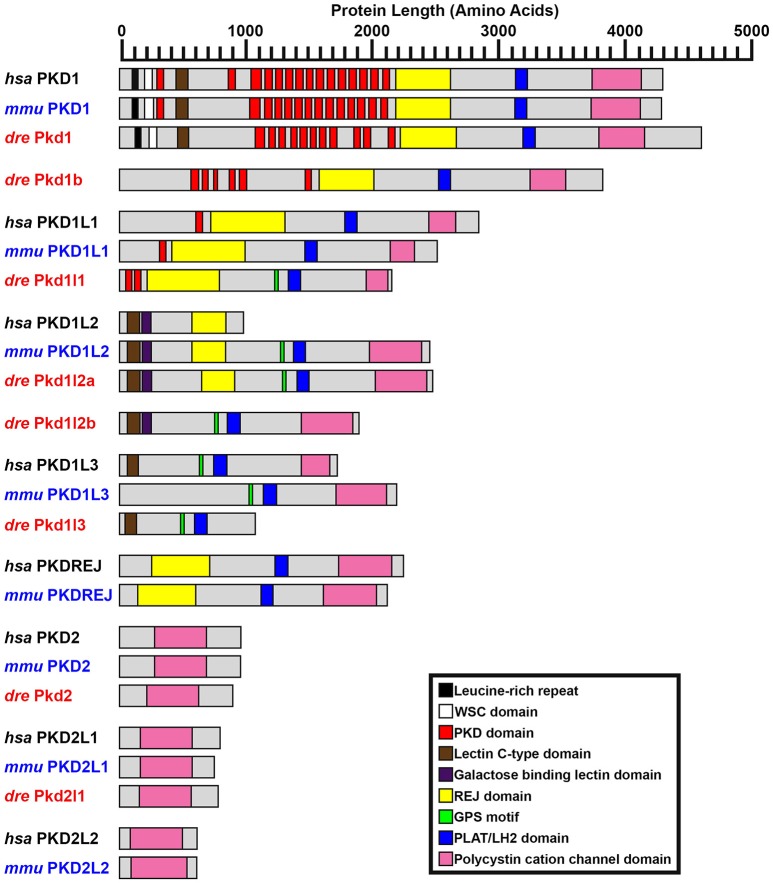
PKD protein domains. Schematics of protein domains identified in all eight human (Homo sapiens, hsa) and mouse (Mus musculus, mmu) and seven zebrafish (Danio rerio, dre) PKD proteins. The zebrafish putative partial pkd1l3 ortholog is also shown. Approximate protein length is indicated by scale at top. Where multiple transcripts exist in Ensembl, the longest protein isoform is shown. In all three species, PKD1 is the longest PKD protein and the only protein to contain a leucine-rich repeat and carbohydrate-binding WSC domain in the amino-terminus. Pkd1b is not present in mammals. Zebrafish Pkd1b resembles Pkd1 with multiple PKD domain repeats in the amino-terminus and REJ, PLAT/LH2, and polycystin-cation-channel domains in the carboxy-terminus. In all three species, PKD1L1 contains a shorter polycystin-cation-channel domain, approximately half the size of that in other Pkd proteins. Unlike mammals, zebrafish Pkd1l1 also contains a GPS motif upstream of the PLAT/LH2 domain. The 5′ coding sequence of mouse Pkd1l1 gene is presently incomplete. PKD1L2 is unusual in humans in that, according to information on Ensembl, longer transcripts represent polymorphic pseudogenes that have acquired mutations, preventing them from being expressed as functional proteins. As a result, the current version of human PKD1L2 is half the size of mouse and zebrafish Pkd1l2 and lacks the polycystin-cation-channel domain characteristic of PKD proteins. If this is correct, then this suggests that human PKD1L2 is no longer a bona-fide PKD gene. Mouse PKD1L2 and Zebrafish Pkd1l2a and Pkd1l2b have identical domain structures, with the exception that Pkd1l2b lacks the REJ domain. PKD1L3 protein structure differs slightly between mammals. Human PKD1L3 has a Lectin C-type domain in the amino-terminus and mouse PKD1L3 does not. In addition, the polycystin-cation-channel domain in mouse PKD1L3 is 411 amino acids long, compared to only 237 amino acids in human PKD1L3. We have identified a putative partial pkd1l3 ortholog in zebrafish, but the sequence lacks the polycystin-cation-channel domain, so we do not consider it a bona-fide pkd gene. Pkdrej and Pkd2l2 are not present in zebrafish. The only currently identified domain in PKD2, PKD2L1, and PKD2L2 proteins is the polycystin-cation-channel domain.